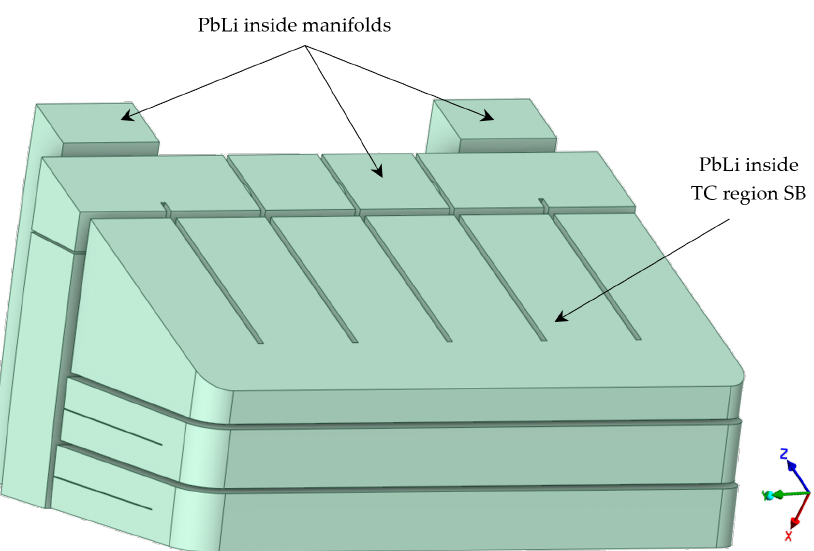
Figure 3. Breeder geometric domain.